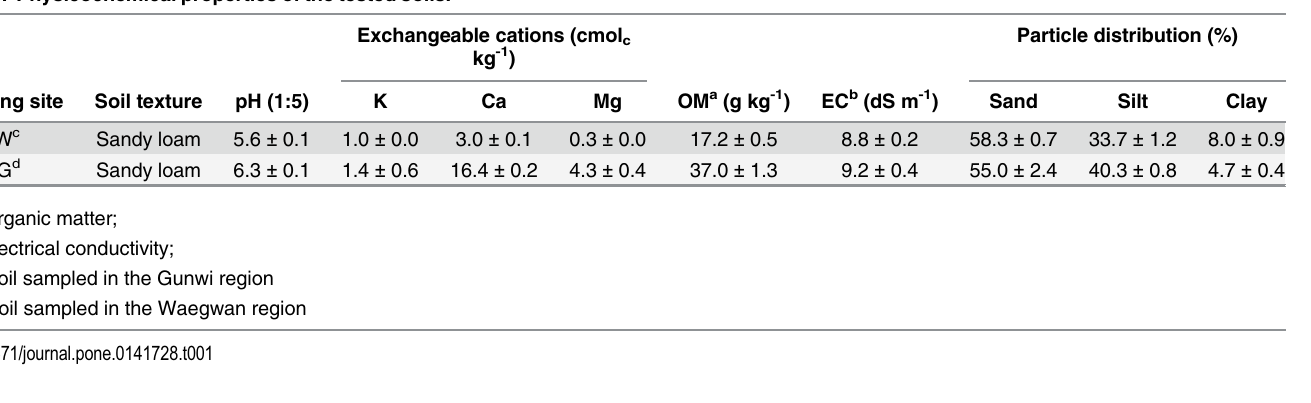
Table 1. Physicochemical properties of the tested